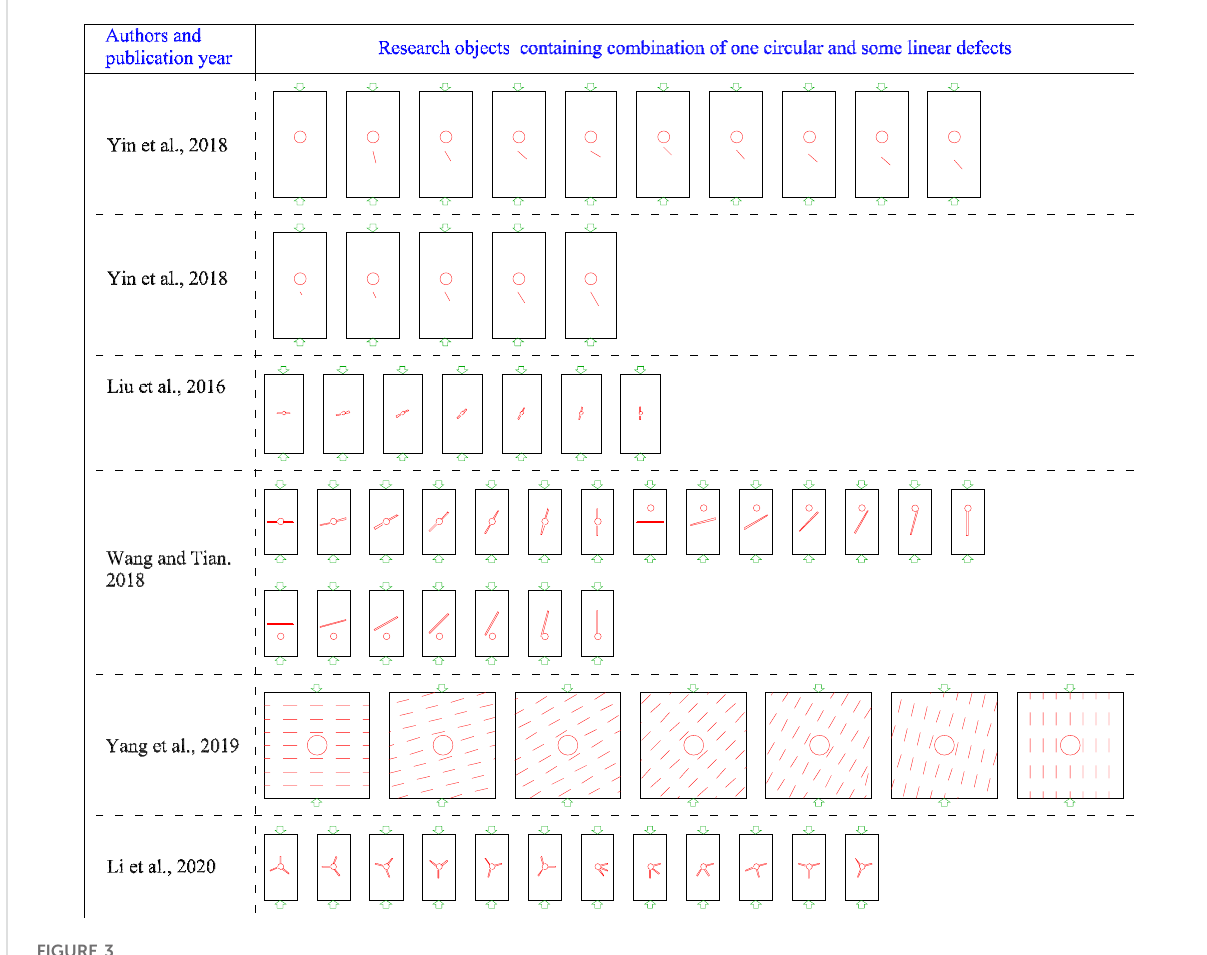
Rock or rock-like specimens containing combination of one circular and some linear